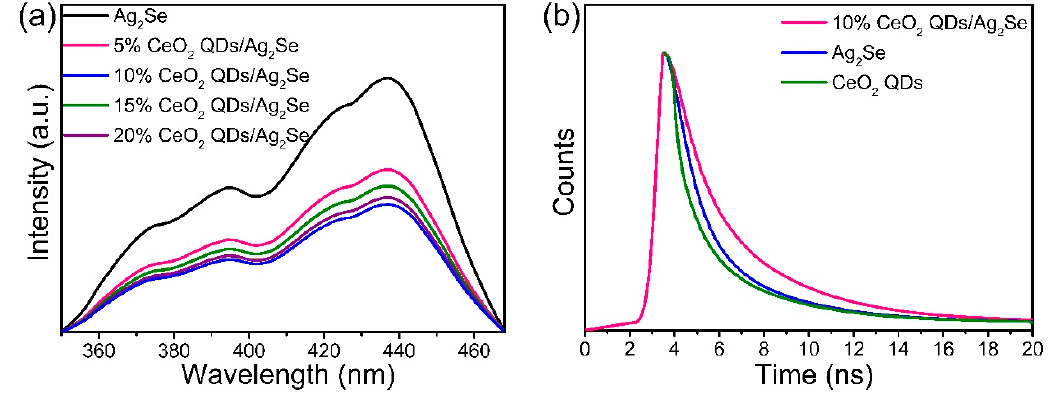
Figure 8. ( a ) Photoluminescence spectra and ( b ) transient PL plots of the different